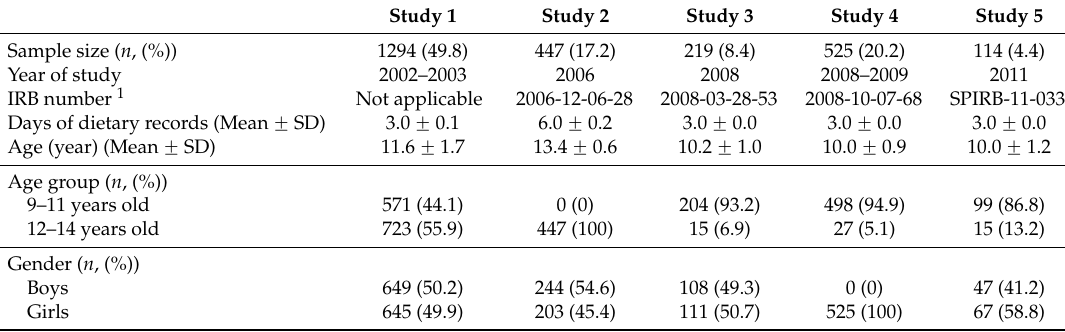
Table A1. Outlines of the five studies used in this